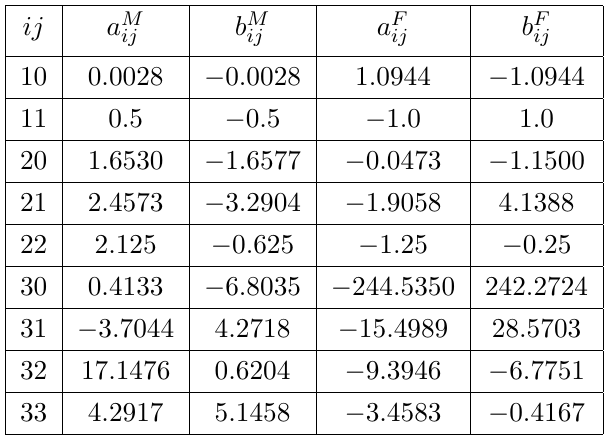
and b M;F for the input parameters given in the ij ij